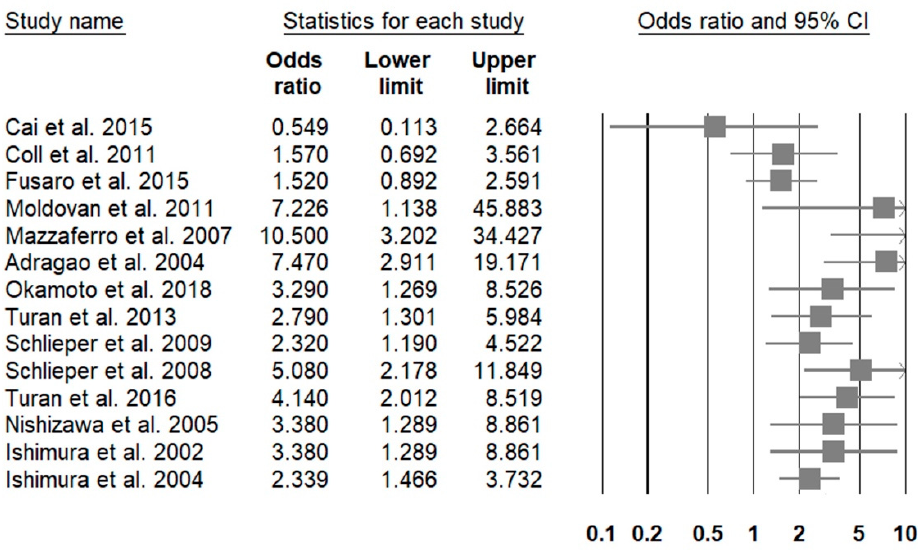
Figure 3. A forest plot showing the male to female risk among patients with dialysis-dependent chronic kidney disease.